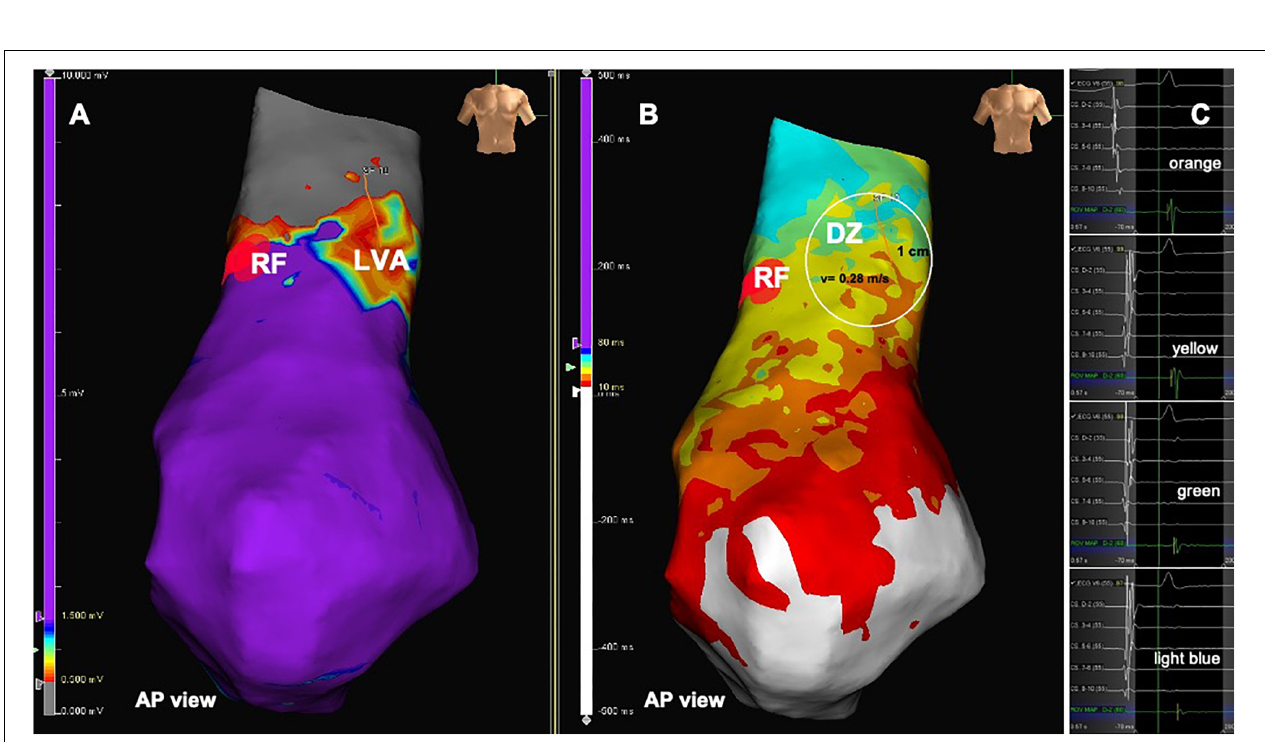
FIGURE 9 | Patient from the PVC group with DZ at a LVA but the earliest activation site located outside the DZ. (A) voltage map in sinus rhythm with LVA in the RVOT free, red dots at site of origin of the PVCs. (B) RVOT isochronal map in sinus rhythm with DZ in the RVOT free wall, red dots at the site of origin of the PVCs outside the DZ. (C) Intracardiac electrograms corresponding to the respective isochrones presented in the isochronal map. Red dots in (A,B) corresponding to radiofrequency applications. DZ, deceleration zone; EAS, earliest activation site; LVA, low voltage area; PVC, premature ventricular contractions; RF, radiofrequency applications; RVOT, right ventricular outflow